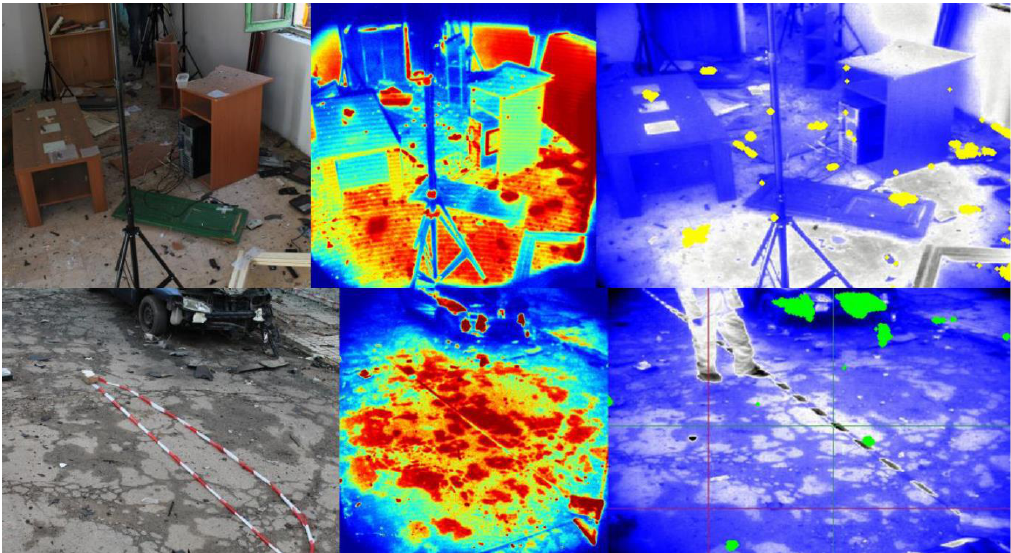
Figure 5. On the left, pictures of the scene scanned by the LIF sensor. In the center, fluorescence images of the scenes filtered at 340 nm. On the right, reflectance images of the areas with locations of polypropylene, polyethylene, and polyester debris (colored dots).